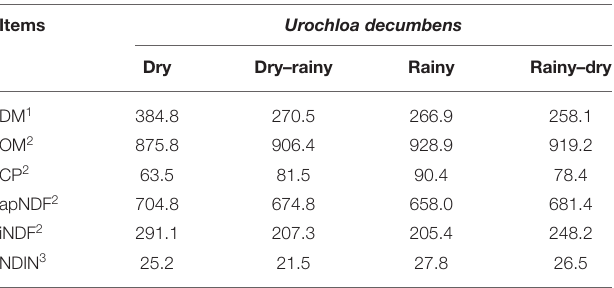
TABLE 1 | Forage chemical composition.